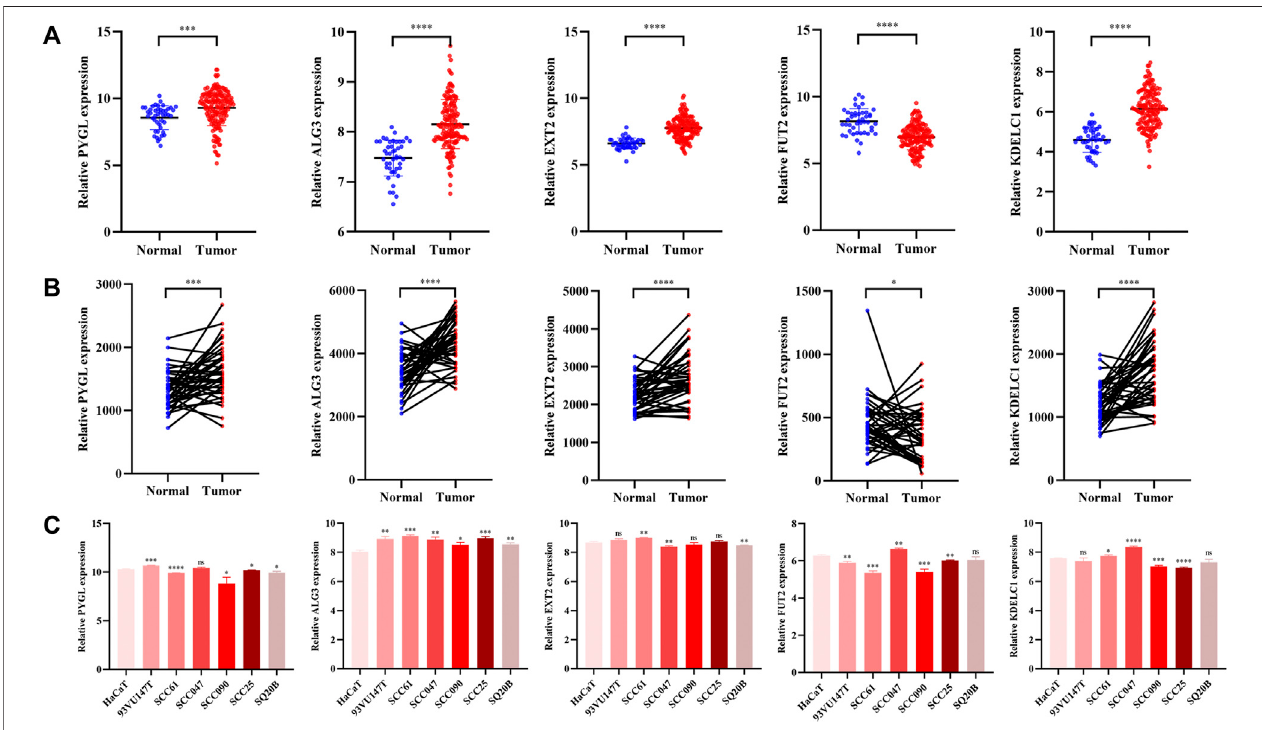
FIGURE 9 | Expression and prognosis validation of the fi ve glycosyltransferases. (A) Difference in the mRNA level of the fi ve genes between 45 normal and 167tumortissuesintheGSE30784dataset. (B) DifferenceinmRNAlevelofthe fi vegenesbetween40matchednormalandtumortissuesintheGSE37991dataset. (C) mRNA level of the fi ve genes in one normal cell line (HaCaT) and six HNSC cell lines (93VU147T, SCC61, SCC047, SCC090, SCC25, and SQ20B) in the GSE62027 dataset. (D) Immunohistochemistry images of the four glycosyltransferases in oral mucosa and HNSCC tissues from the HPA database. (E) Protein levelofthefourproteinsbetweennormalandtumortissuesintheUALCANdataset. (F) KMcurvesofthe fi vegenesinHNSCCpatientsthroughtheKM-plotterdatabase. (* p < 0.05; ** p < 0.01; *** p < 0.001; **** p <